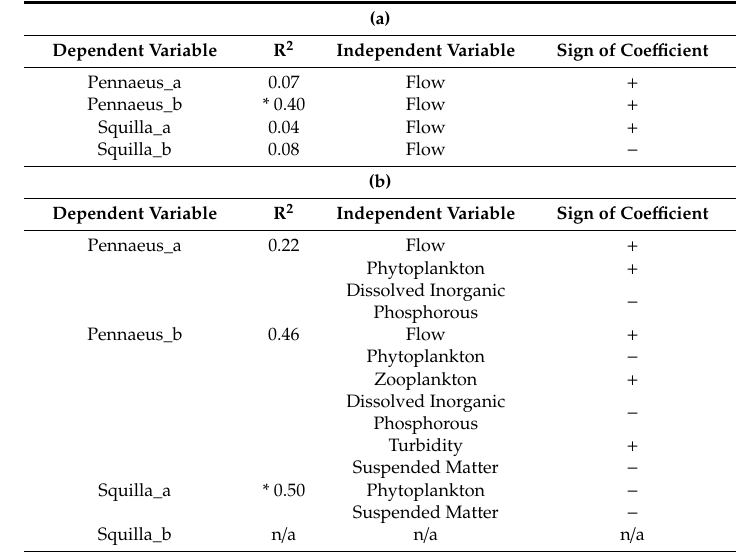
Table 7. ( a ) Coe ffi cients of determination (R 2 ) of general linear models (GLMs) using the selected fishery taxa and techniques (a: trawling; b: other techniques) as the dependent variable and annual flows based on hydrological year (Flow) as the independent variable. ( b ) Results using annual flows and physicochemical variables (see Table 3 for details) as independent variables, through a stepwise selection procedure.